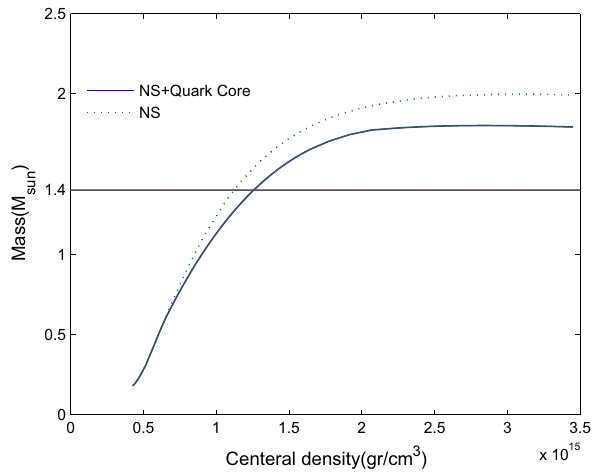
Fig. 3 Mass-the central density relation for the neutron stars with and without the quark matter